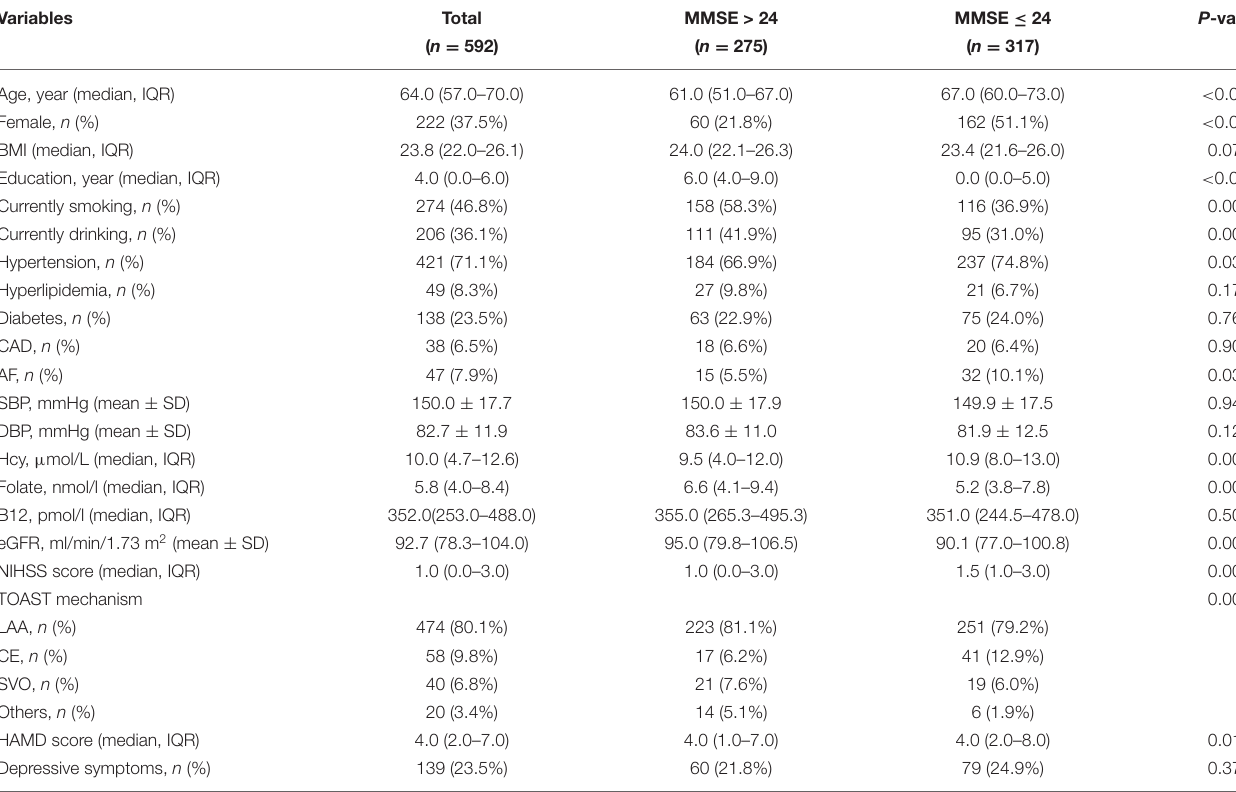
TABLE 1 | Baseline characteristics of patients with AIS grouped by cognitive impairment according to MMSE.